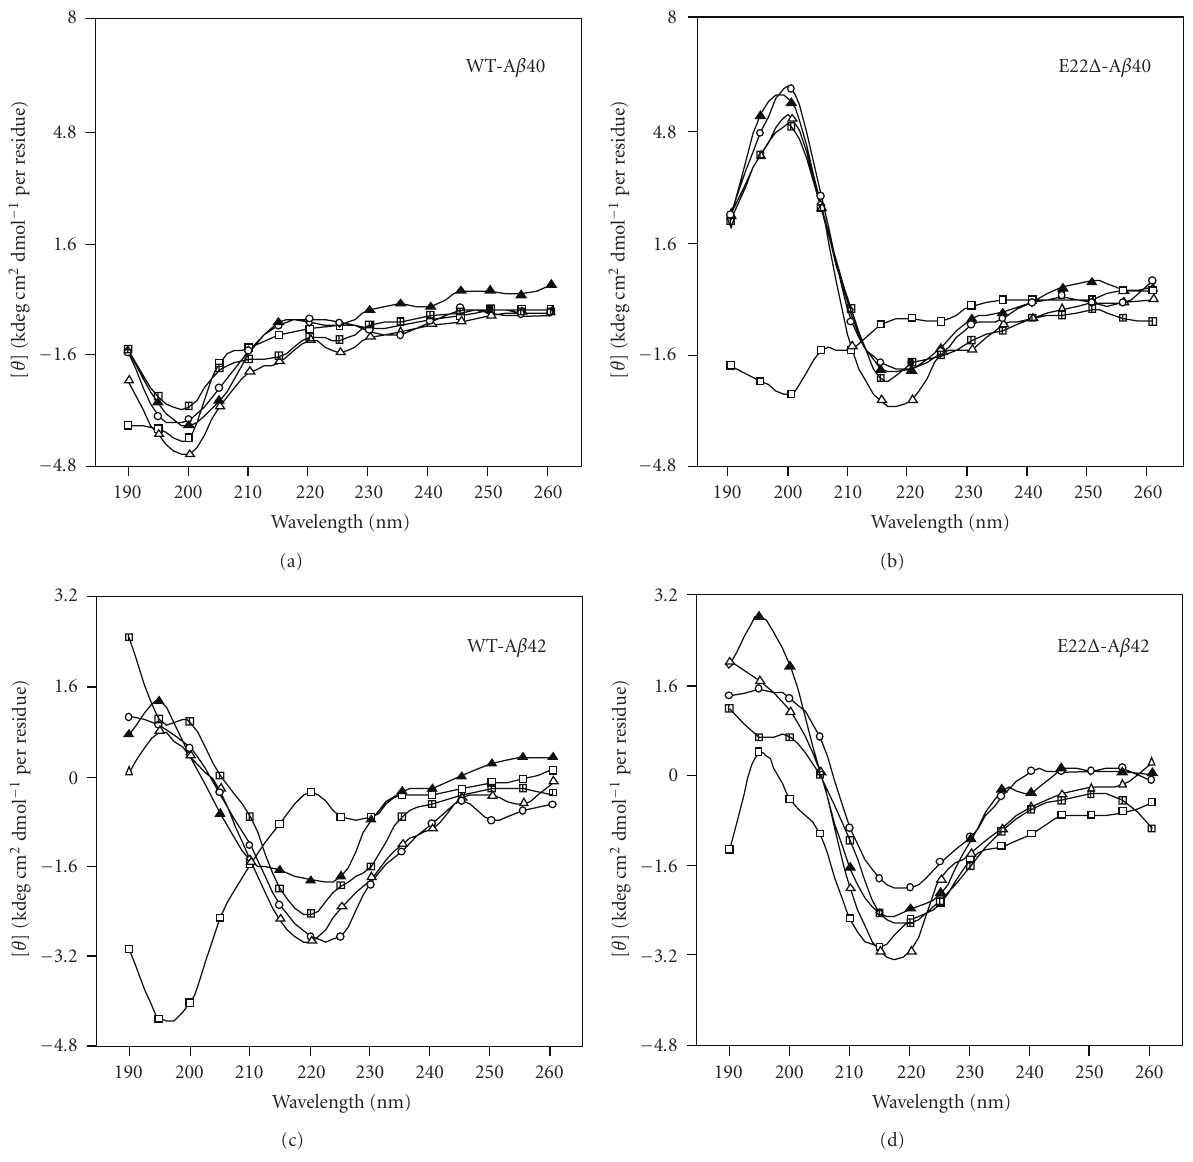
Figure 2: CD spectra of E22 Δ -A β 40 and E22 Δ -A β 42 (25 μ M). (a) A β 40, (b) E22 Δ -A β 40, (c) A β 42, (d) E22 Δ -A β 42. Each A β (25 μ M) was incubated in phosphate bu ff er at 37 ◦ C for the following times: (cid:3) , 0h; (cid:2) , 4h; (cid:3) , 8 h; ◦ , 24 h; (cid:4) ,48h.